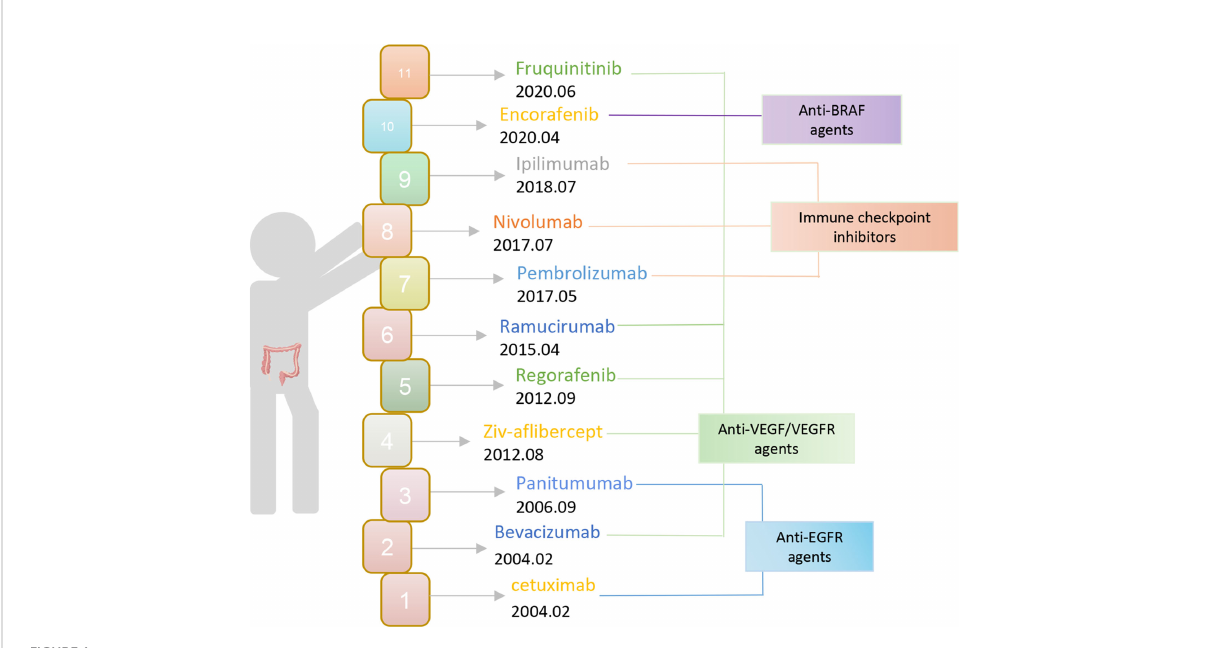
FIGURE 1 The FDA approves immunotherapy for